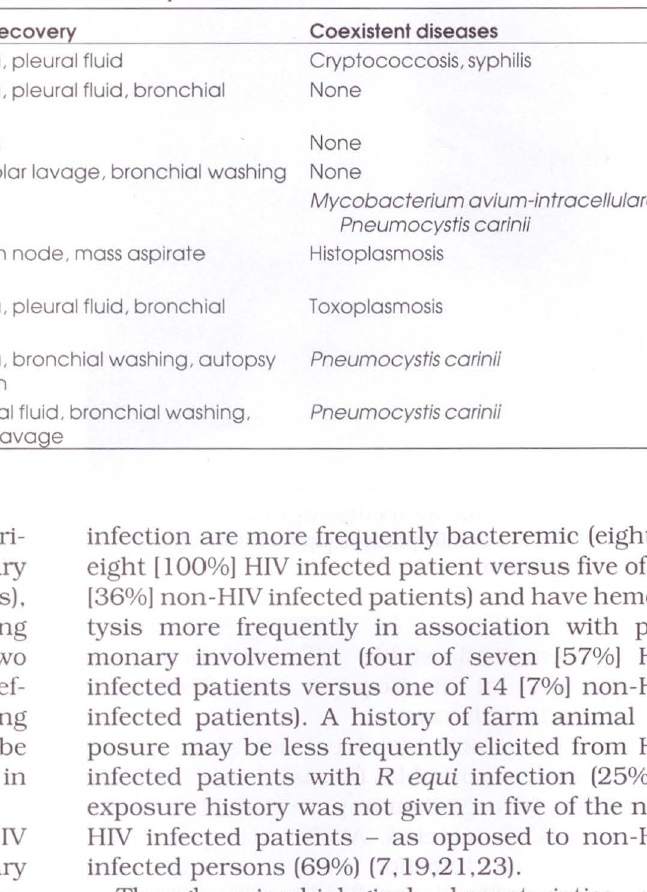
Spectrum of Rhodococcus equi disease in human immunodeficiency virus infection Reference Case Sites of